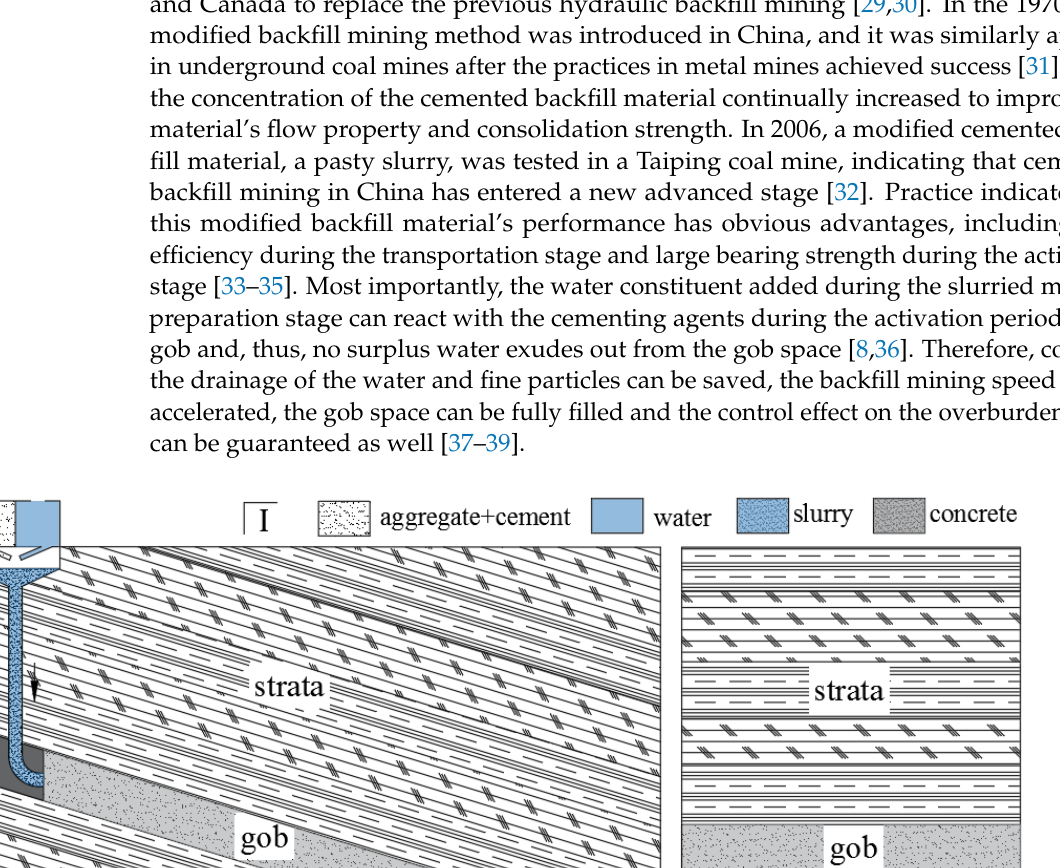
50 Figure 8. Percentages of the different participants in cemented backfill material. Coal gangue: The most common coarse aggregate in the cement filling material is coal gangue. It is the incombustible rock mass produced during underground coal mining processes, such as the coal cutting procedure at the coal mining face and the blasting pro- cedure at the roadway driving face [28,43]. According to statistics, the quantity of coal gangue comprises approximately 30% of the whole coal production in China, with more than 60% coming from the coal preparation procedure [44,45]. The original coal gangue is always large in size and of poor grading, and it should be cracked to an appropriate lump- iness to facilitate the following transportation and activation processes [46]. An SEM im- age of coal gangue is provided in Figure 9a. 0 10 2 0 3 0 40